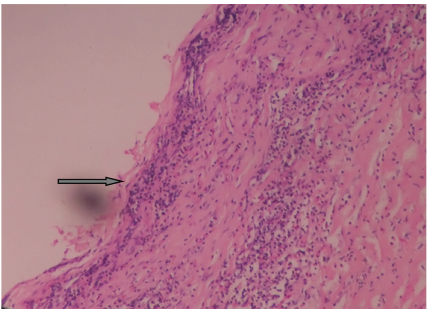
Figure 3: Photomicrograph (haematoxylin and eosin section; × 10 magnification) showing columnar and flattened epithelium of cyst with focal aggregate of chronic inflammatory cells supported by fibrocollagenous cyst